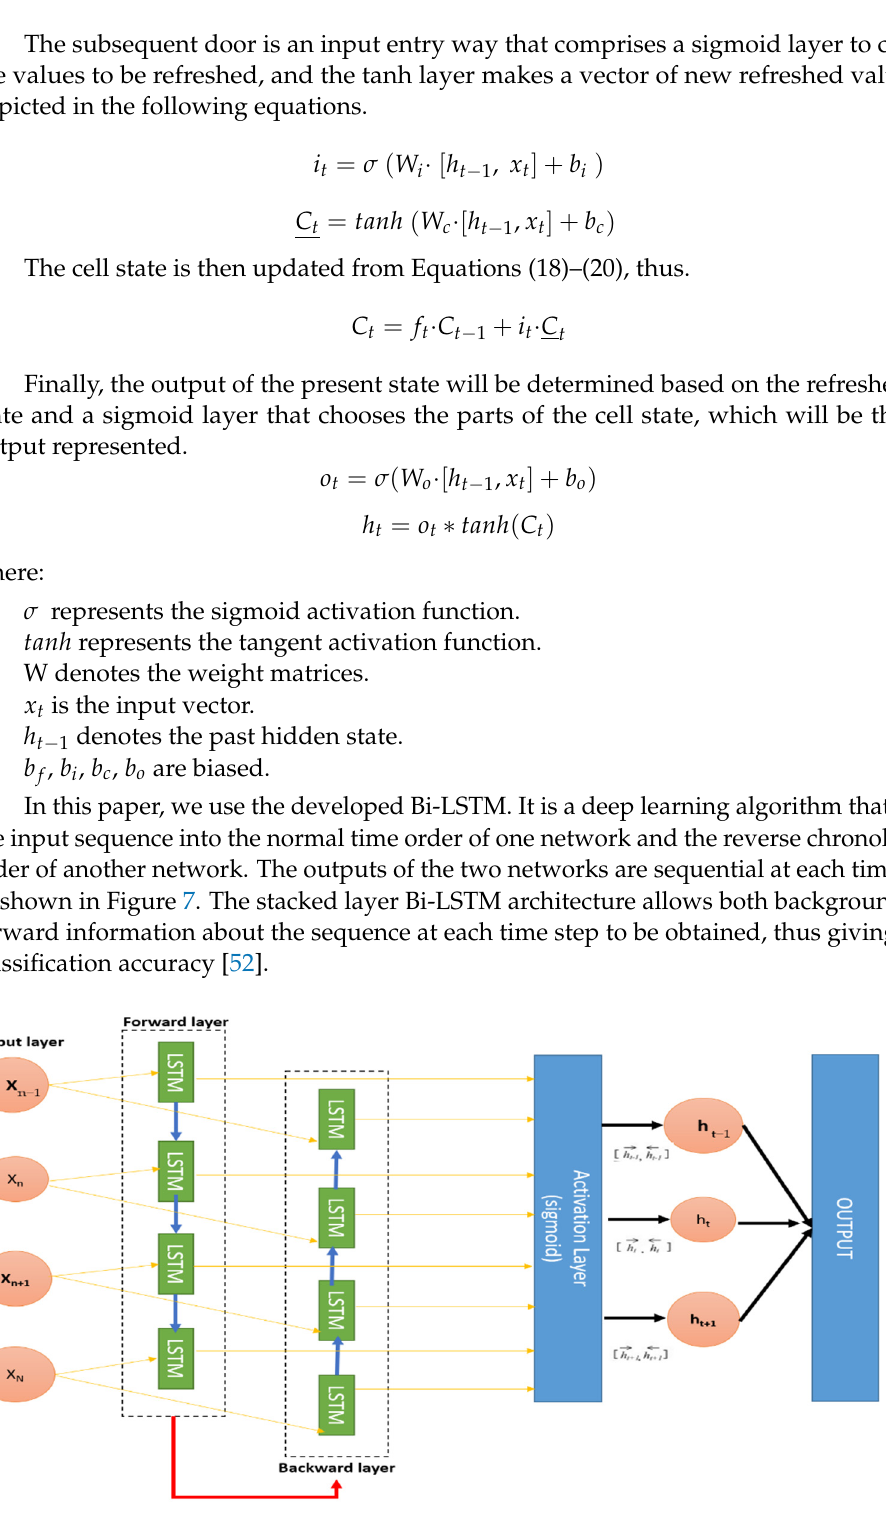
Figure 7. Structure of Bi-LSTM. Source: [52].